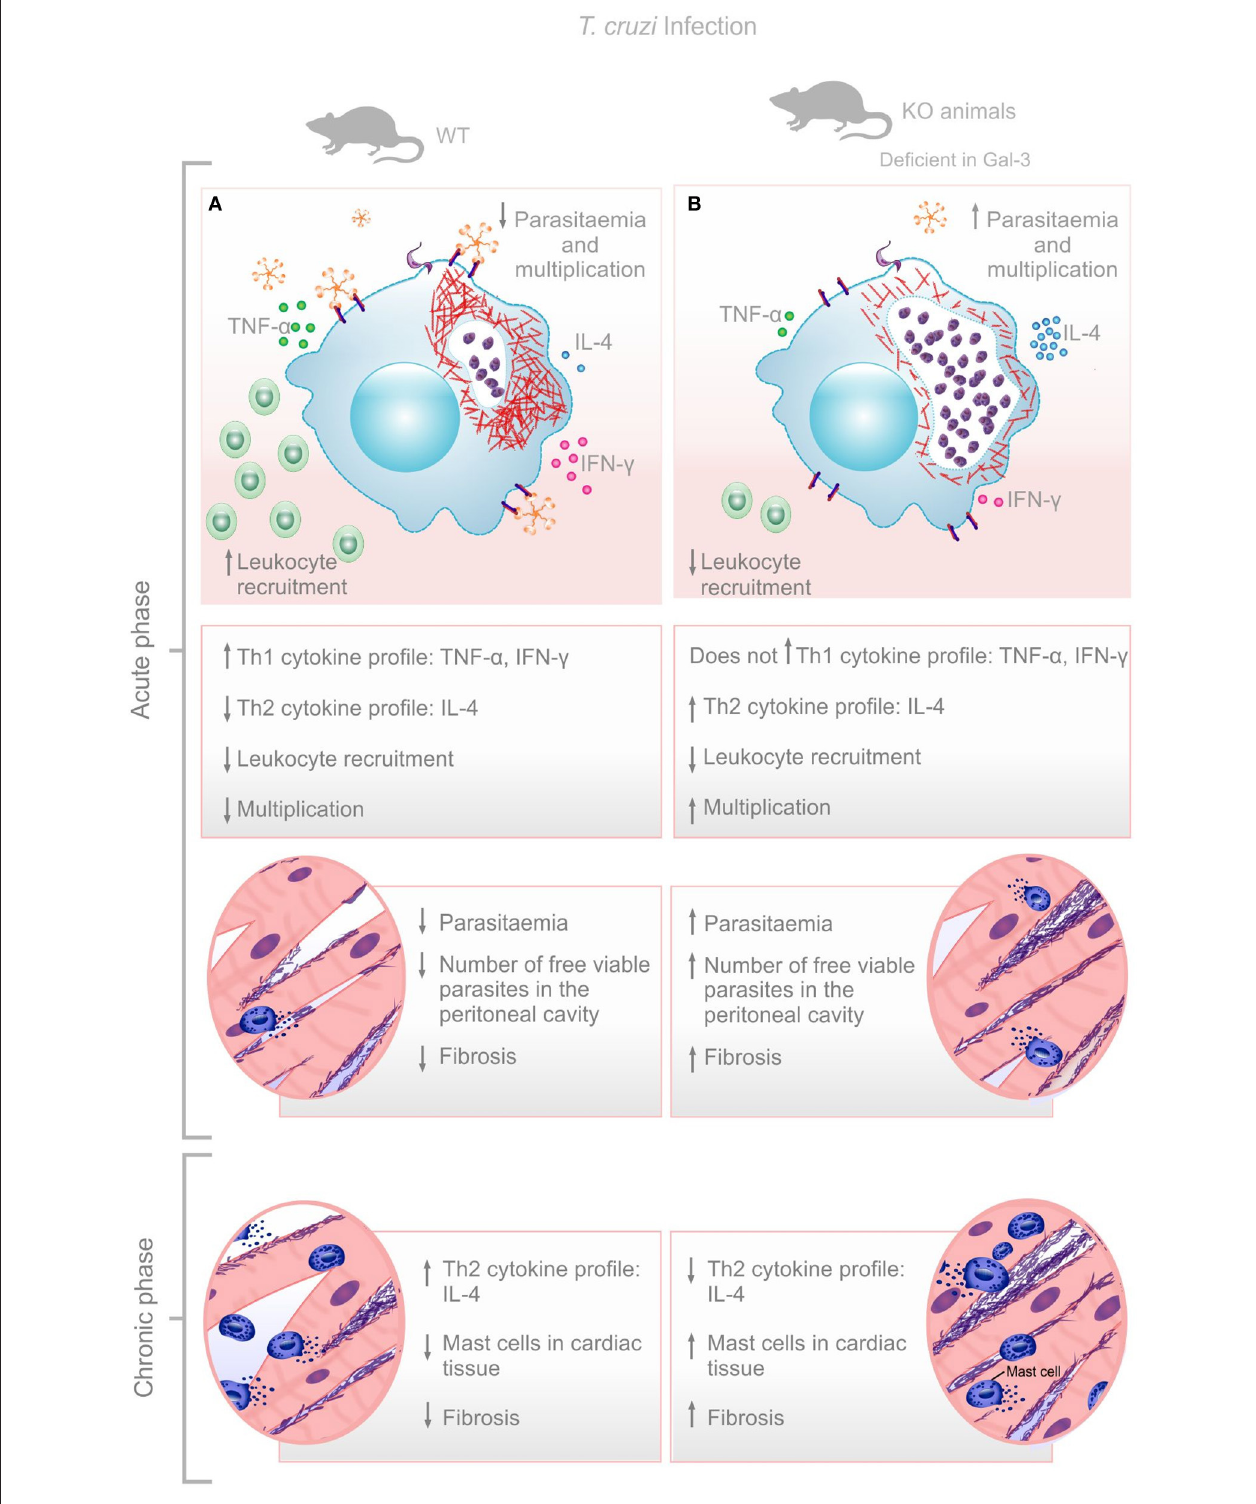
FIGURE 4 | Envisaged mechanism involving Gal-3 in T. cruzi infection control. Gal-3 expression ensures macrophage recruitment, parasite clearance, and balanced Th1/Th2 immune response leading to low bloodstream parasitemia and rapid control of infection with low cardiac damage and fibrosis (A) . Lack of Gal-3 expression lead to low macrophage recruitment, low parasite clearance, and unbalanced Th1/Th2 immune response leading to high bloodstream parasitemia and delay control of infection with high cardiac damage and fibrosis (B) .